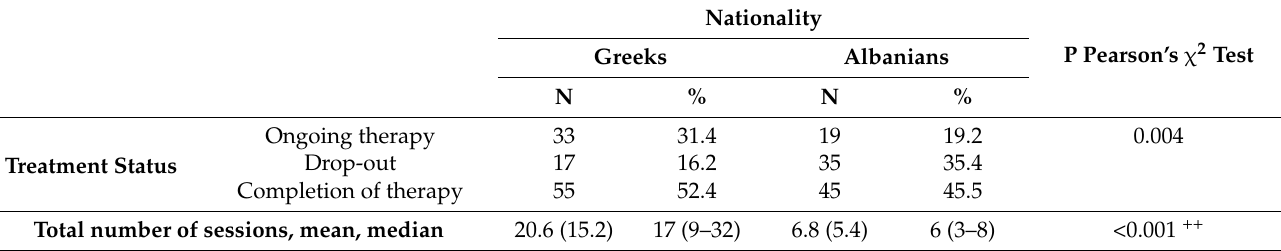
Table 5. Treatment status and total number of sessions in the Mobile